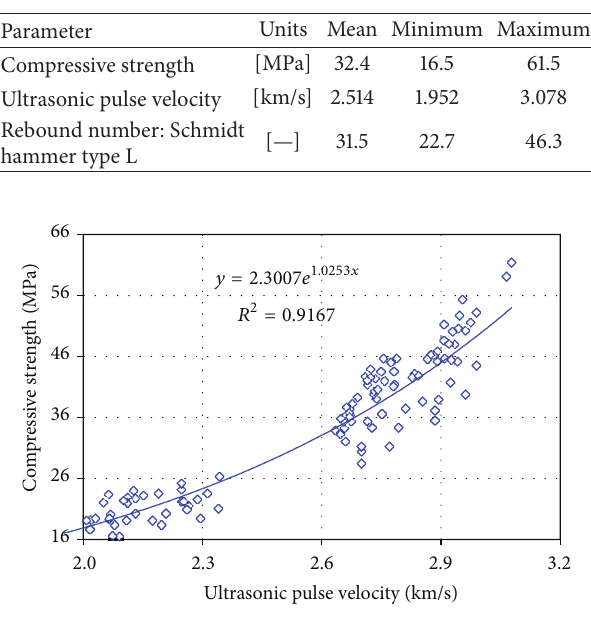
Figure 2: Results of measurements using the ultrasonic pulse method; relationship between ultrasonic pulse velocity and com- pressive strength of calcium silicate bricks.